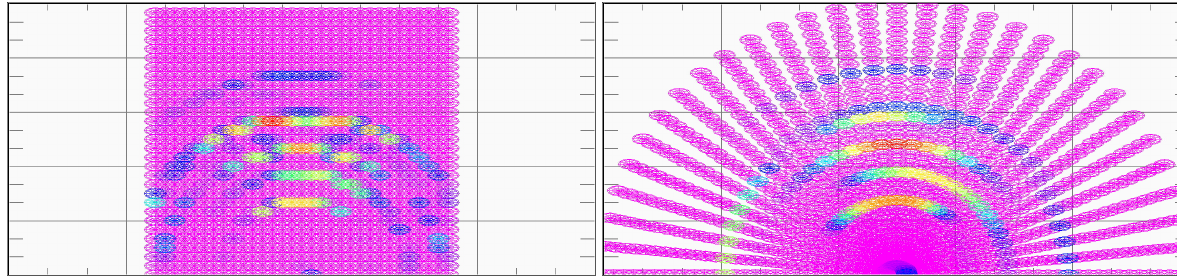
Figure 12. The Cartesian ( left hand side ) and the polar ( right hand side ) coordinate raster with low resolution